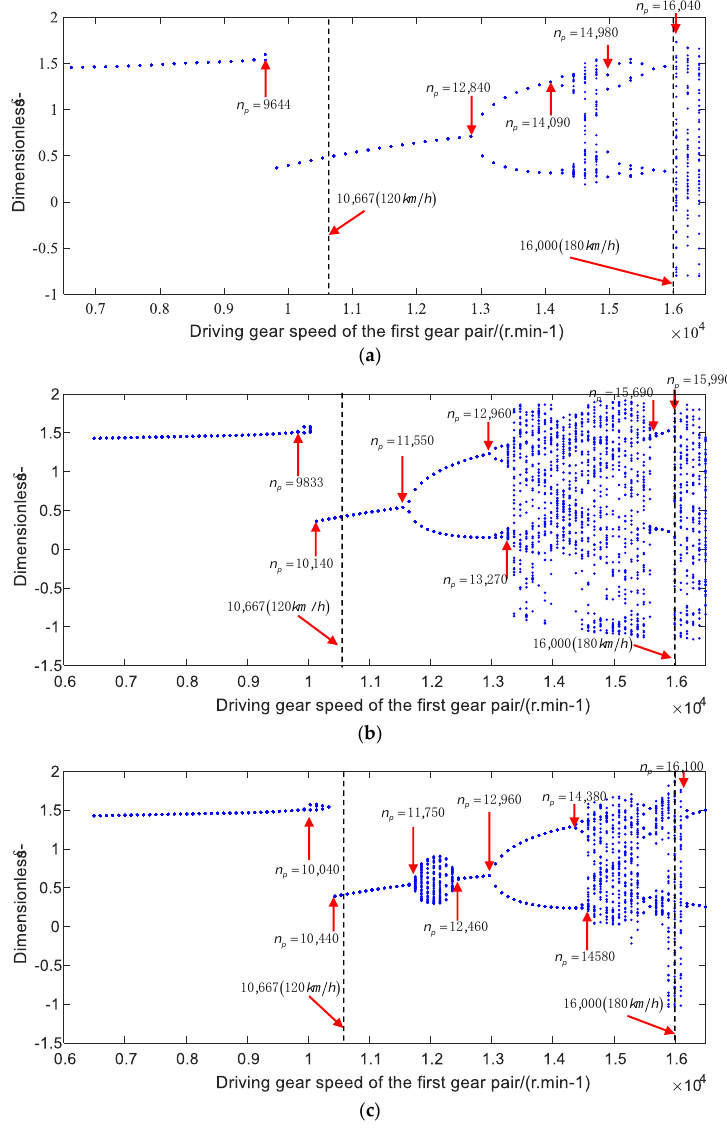
Figure 14. The bifurcated diagrams of gear system for the accelerating working condition: ( a ) constant bearing stiffness, ( b ) variable bearing stiffness values without considering the influence of thermal deformation, and ( c ) variable bearing stiffness values under the influence of thermal deformation.